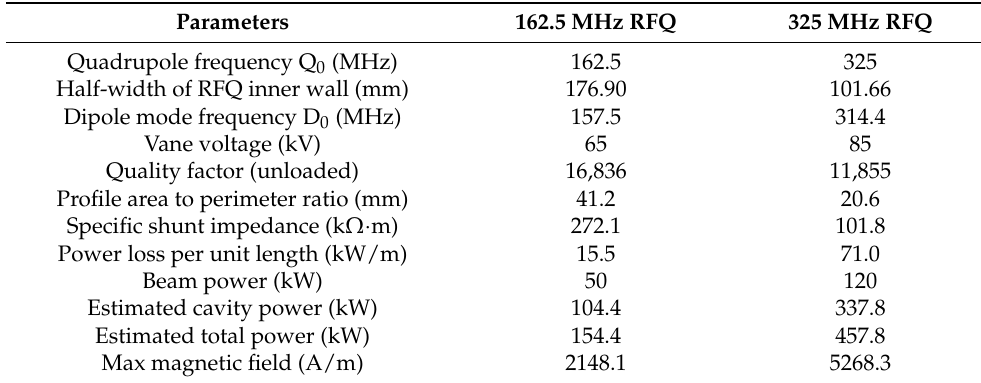
Table 2. Result comparison of 2-dimensional RFQ electrical parameters.